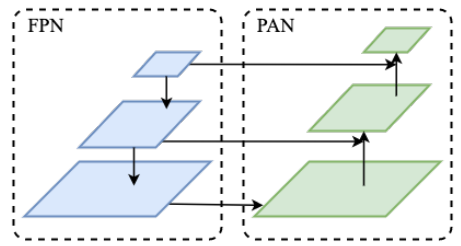
Figure 5. FPN and PAN for YOLOv4.